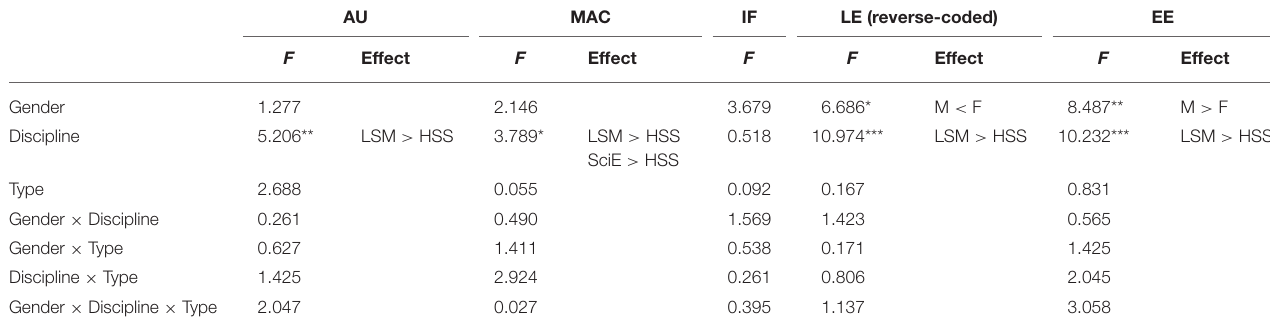
TABLE 4 | Differences in international student engagement by gender, discipline, and institutional type.